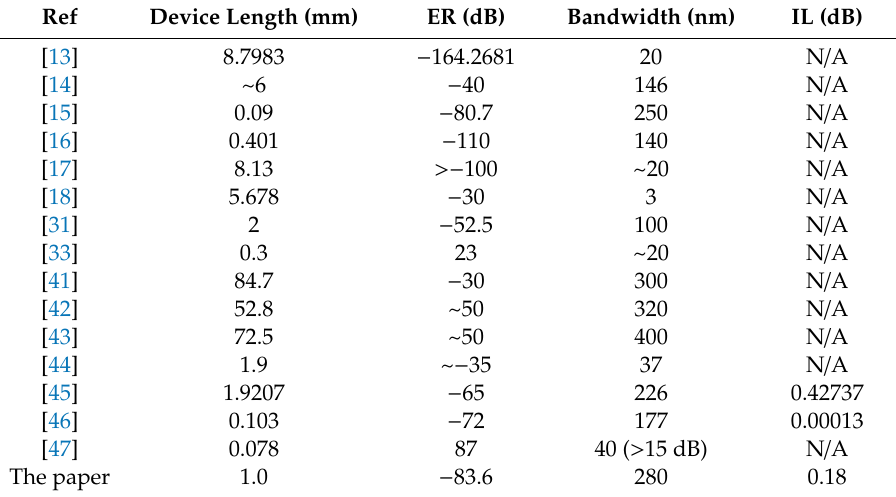
Table 1. Comparison results between the proposed PBS and prior